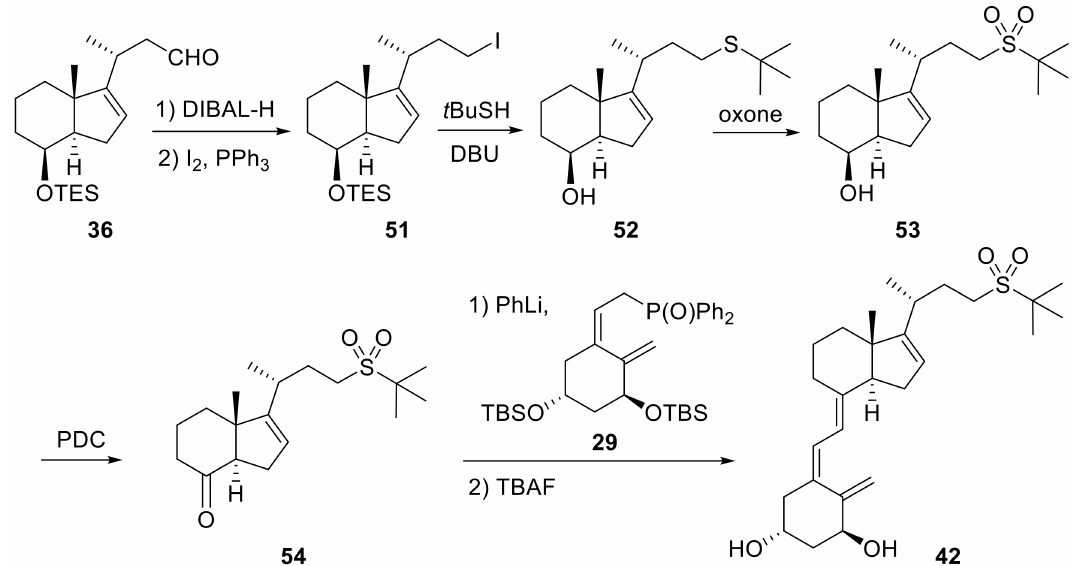
Scheme 6. Synthesis of 23- tert -butylsulfonyl-16-ene-1 α -hydroxyvitamin D analogue ( 42